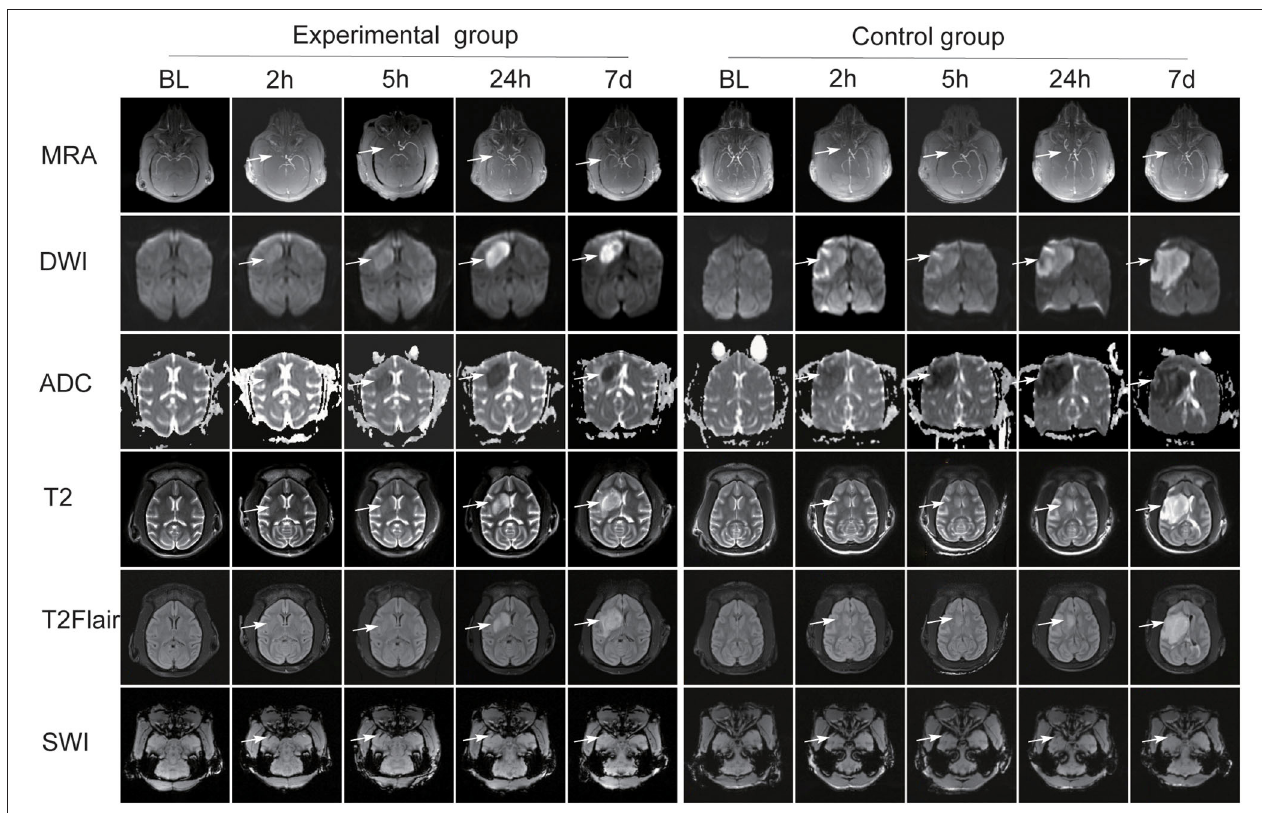
FIGURE 3 | The post-operative MRI image changes in the two groups of animals. Both groups presented different changes over DWI, ADC, SWI, T2, and T2-FLAIR sequences (white arrow). The MCA was absent at 2h after operation. In the experimental group, MCA reconnected on the infarcted side after thrombolytic therapy. In the control group, brain magnetic resonance angiography (MRA) scans revealed the occluded MCA was absent (white